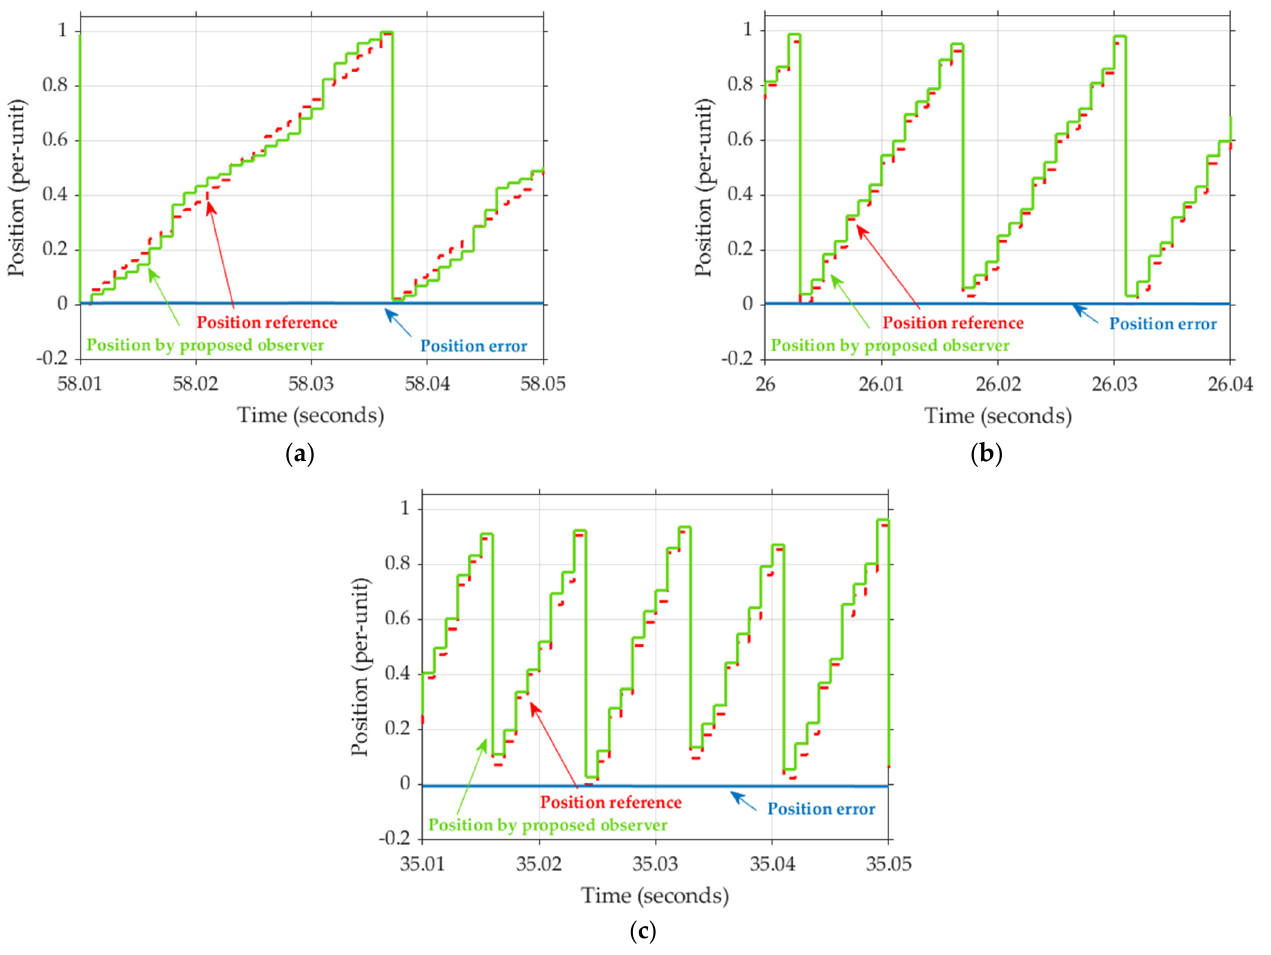
Figure 17. Experimental results for the rotor position at ( a ) 400 rpm, ( b ) 760 rpm and ( c ) 1265 rpm.